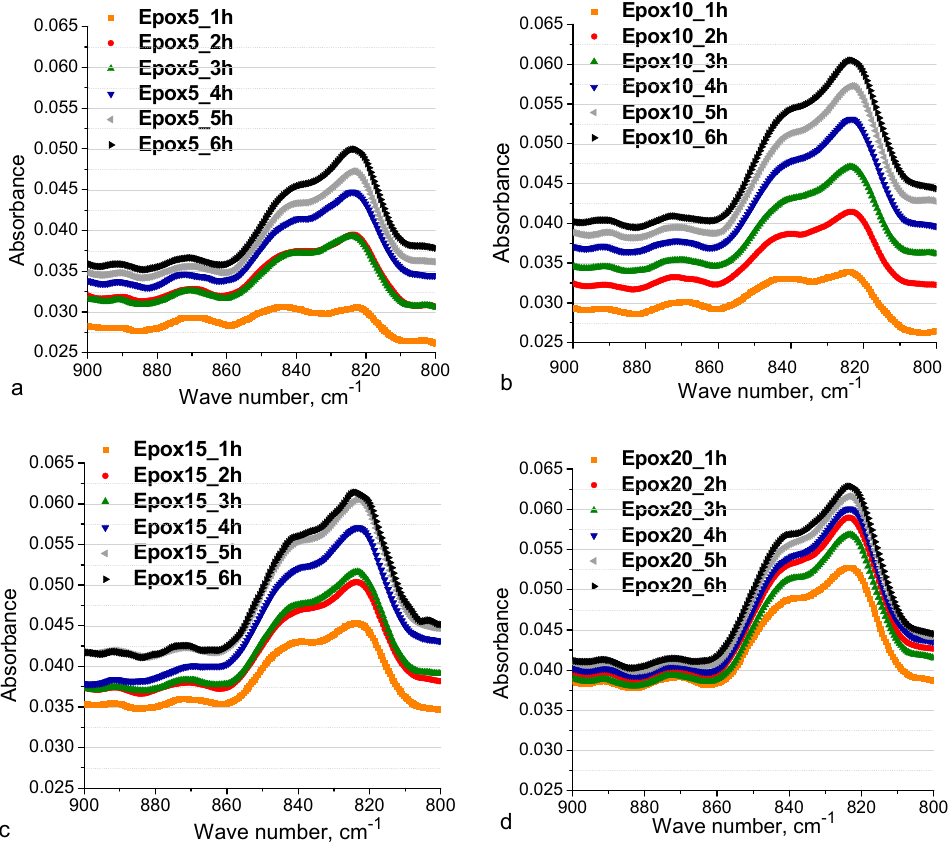
Figure 2. Dependence of absorption band characteristic of epoxy groups on catalyst concentration. ( a ) 5%, ( b ) 10%, ( c ) 15%, and ( d ) 20%.